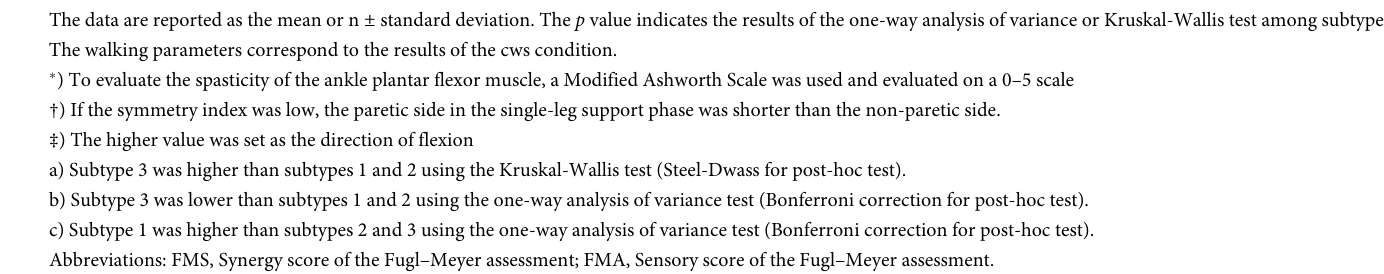
revealed a significant simple main effect of Condition (Fig 2). The lower-limb extension angle showed significant main effects for Condition (F (2, 68) = 9.04, p < 0.001, η p2 = 0.26) and for Subtype (F (2, 34) = 19.5, p < 0.001, η p2 = 0.60) and revealed that the interaction of